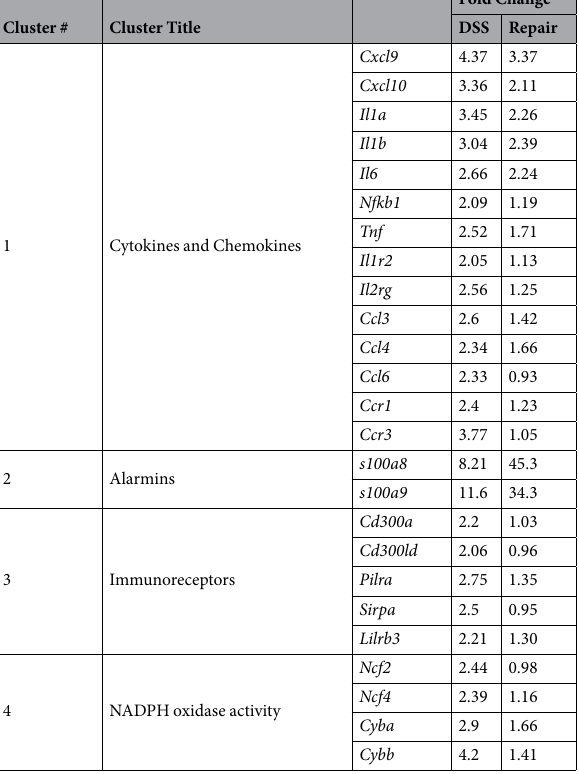
Table 1. Representative eosinophil genes associated with acute inflammation and